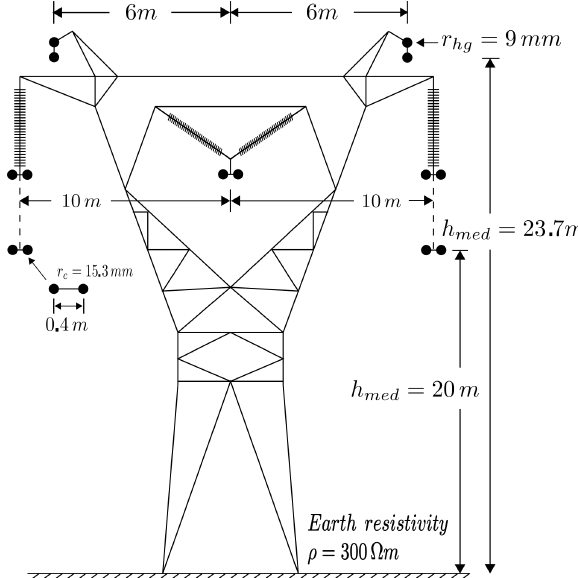
Figure 5. Transversal geometry of the transmission line